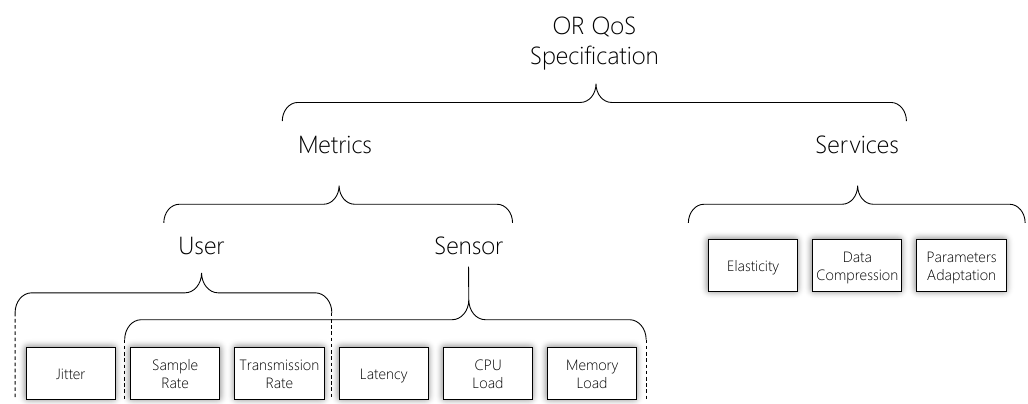
Figure 6. QualiCare QoS taxonomy presenting its the metrics and services.